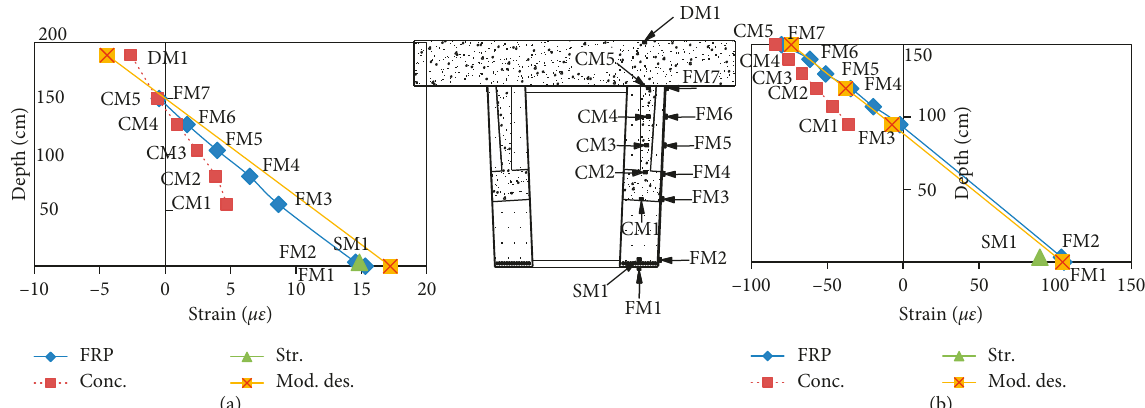
Figure 10: (a) Strain profile due to stop 3 section D-D. (b) Strain profiles due to stage 2 loads section C-C (noncomposite HCB).